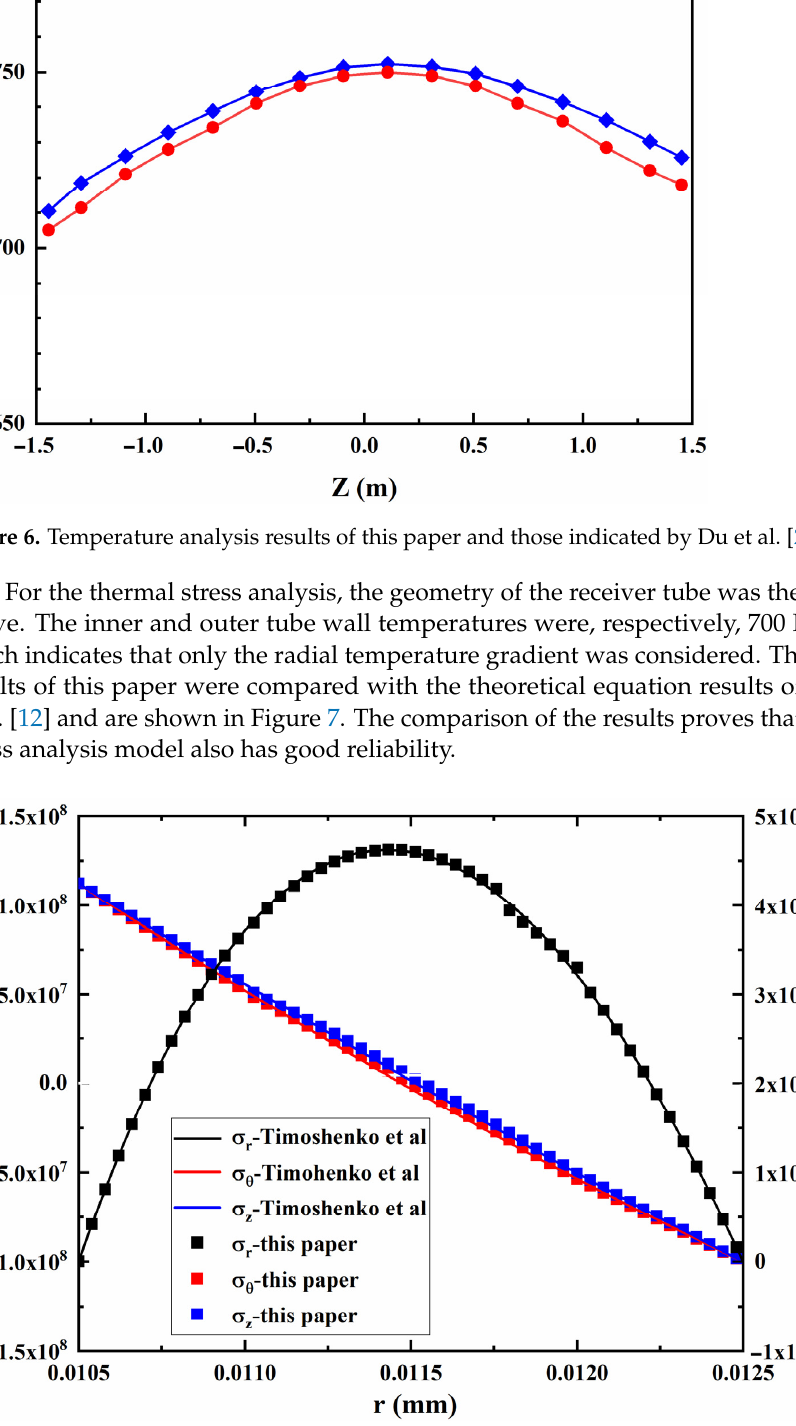
Figure 7. Thermal stress analysis results of this paper and those of Timošenko et al. [12].